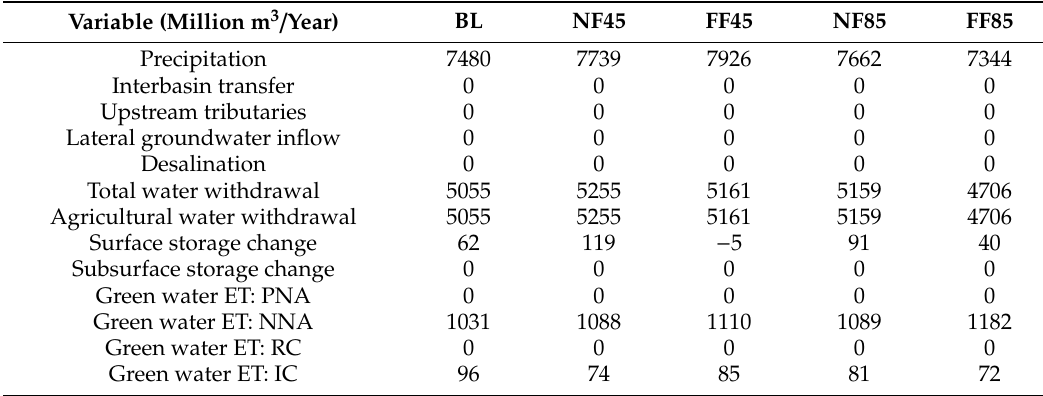
Table A5. Resource base sheet of the Lake Como river basin,